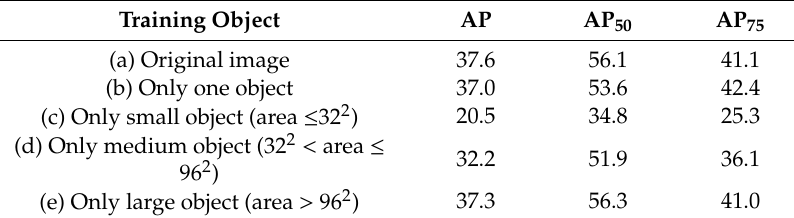
Table 6. Results of five choices of the training